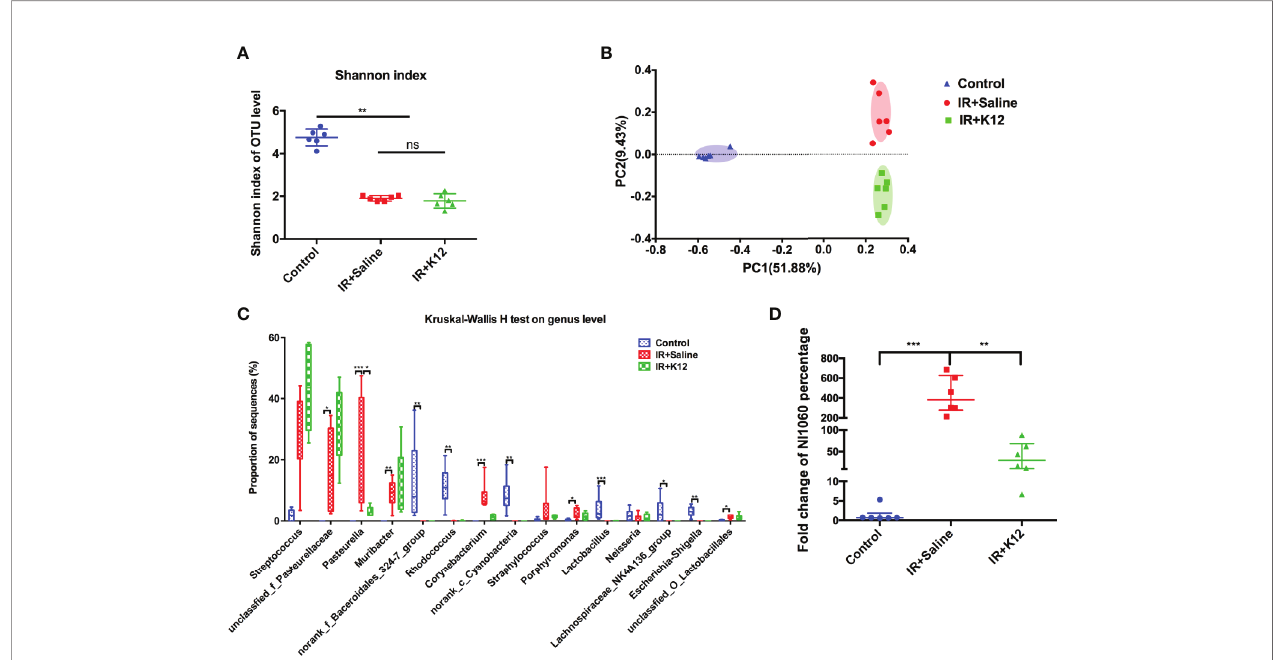
FIGURE 4 | Streptococcus salivarius K12 modulates oral microbiota in RIOM mice. (A) The alpha diversity of oral microbiota. (B) Principal coordinate analysis (PCoA) of oral microbiota based on Bray-Curtis distance. (C) Prevalent genus with signi fi cant difference in abundance. Values are presented as median, interquartile range, minimum, and maximum. Kruska-Wallis H test with post hoc tests applying the Dunn ’ s test for multiple comparisons. (D) qPCR quanti fi cation of NI1060 (mean ± SD). One-way ANOVA test followed by Tukey ’ s test. N=6 per group. ns, not signi fi cant. * P < 0.05, ** P < 0.01, *** P < 0.001.